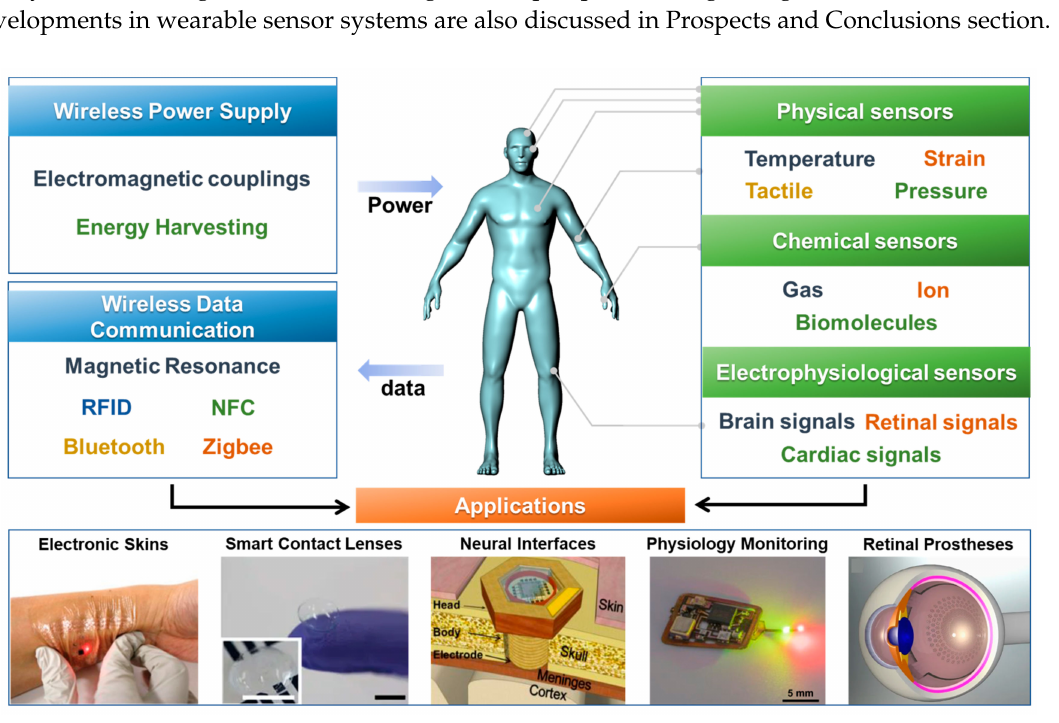
Figure 1. Components in wireless, wearable sensor systems and their representative